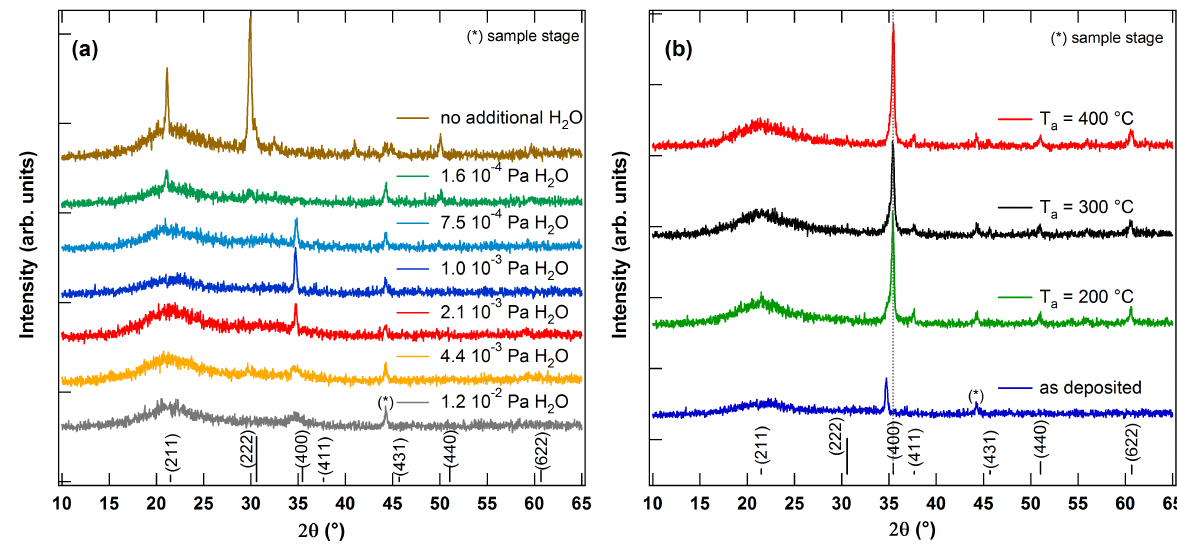
Figure 2. The θ – 2 θ diffractograms of as-deposited films with varying water vapor partial pressure ( a ) and films deposited with 1 . 0 × 10 − 3 Pa H for 2 h at different temperatures ( b ). Prominent reflections from In (PDF 00-006-0416) are indicated for